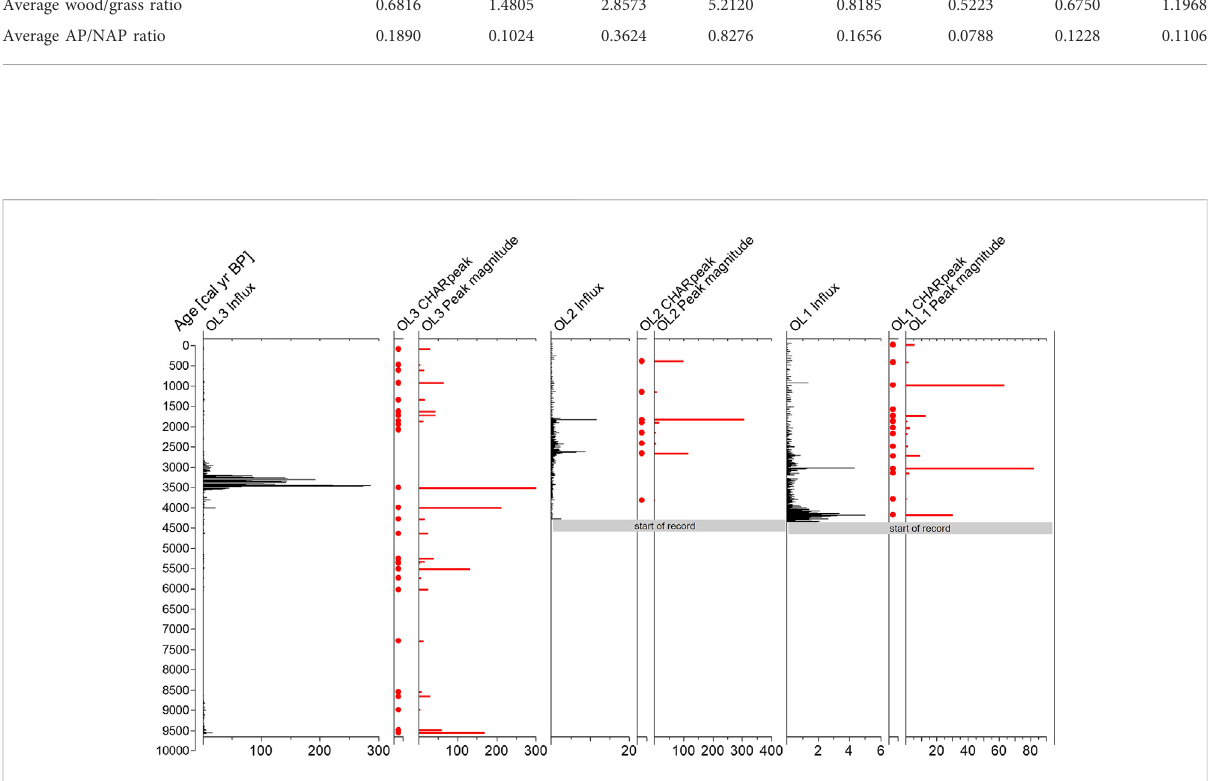
FIGURE 6 Tarvagatai Nuruu NP macro-charcoal in fl uxes (particles/cm 2 yr), peaks, and respective peak magnitudes (particles/cm 2 peak) based on CharAnalysis.